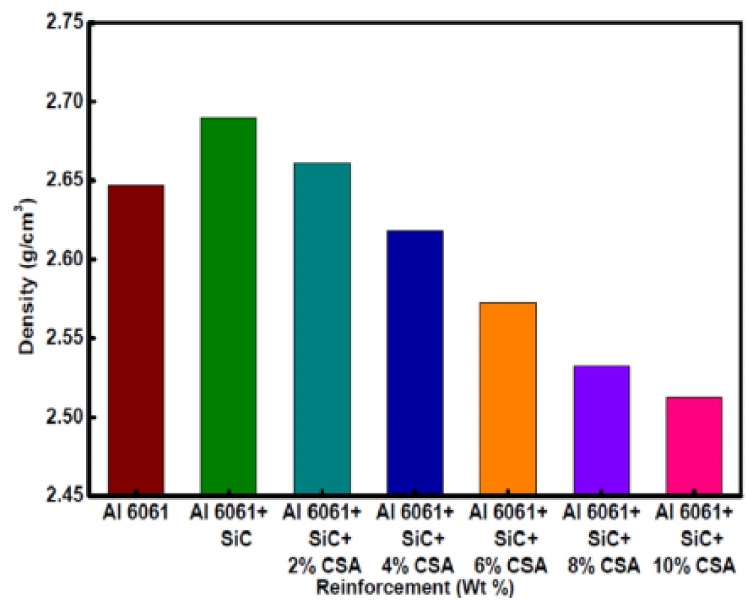
Figure 11. Densities of Al6061 and its composites